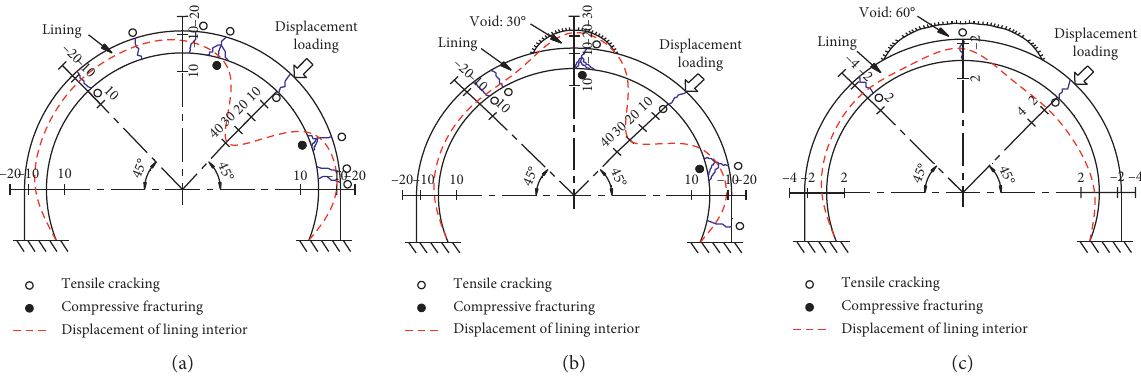
Figure 11: Distributions of the lining, cracking, and deformation at peak load (defects at the crown, displacement unit: mm): void sizes of (a) 0 ° , (b) 30 ° , and (c) 60 ° .